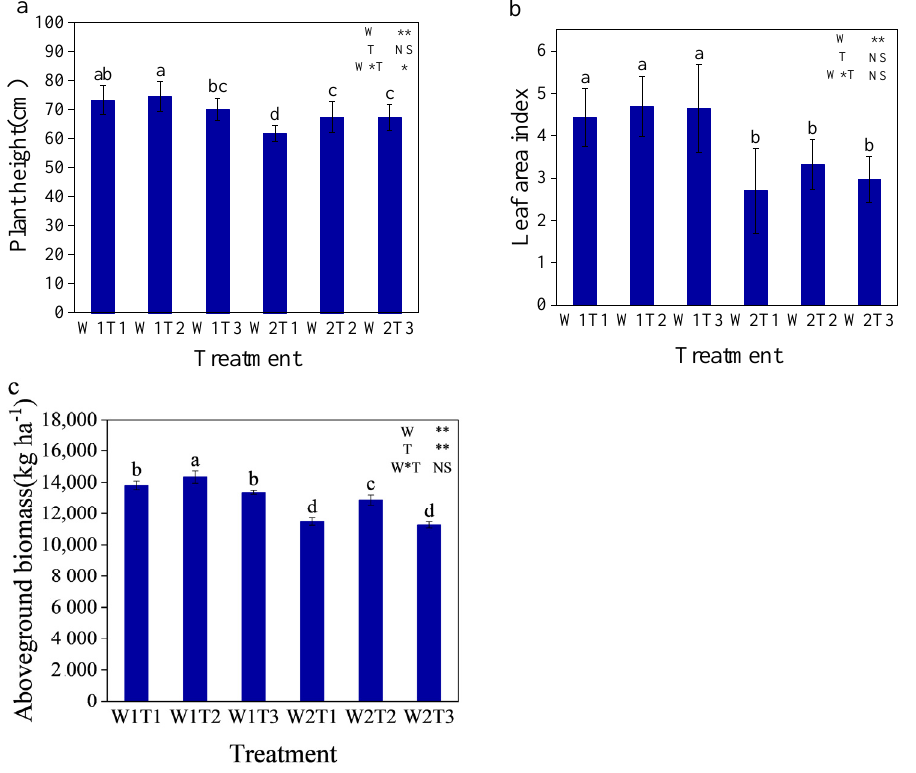
Figure 4. Effect of irrigation and fertilization timing on ( a ) plant height and ( b ) leaf area index at booting stage and ( c ) aboveground biomass accumulation at filling stage of winter wheat. Values are means ± standard deviation ( n = 3). Data columns with different letters on top are significantly different at p < 0.05. NS means p > 0.05, the difference is not significant. *, ** mean significant at p < 0.05 and p < 0.01, respectively.